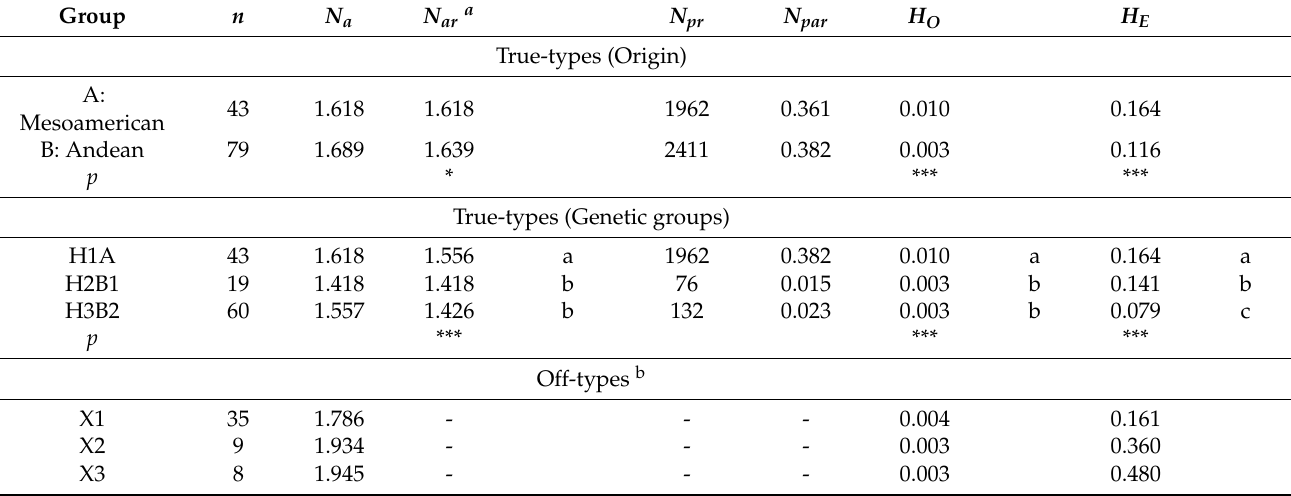
Table 4. Genetic diversity of Croatian common bean accessions based on SNP markers. True-type accessions were classified according to (1) centres of origin (A: Mesoamerica, B: Andean) and (2) genetic groups (H1A, H2B1,